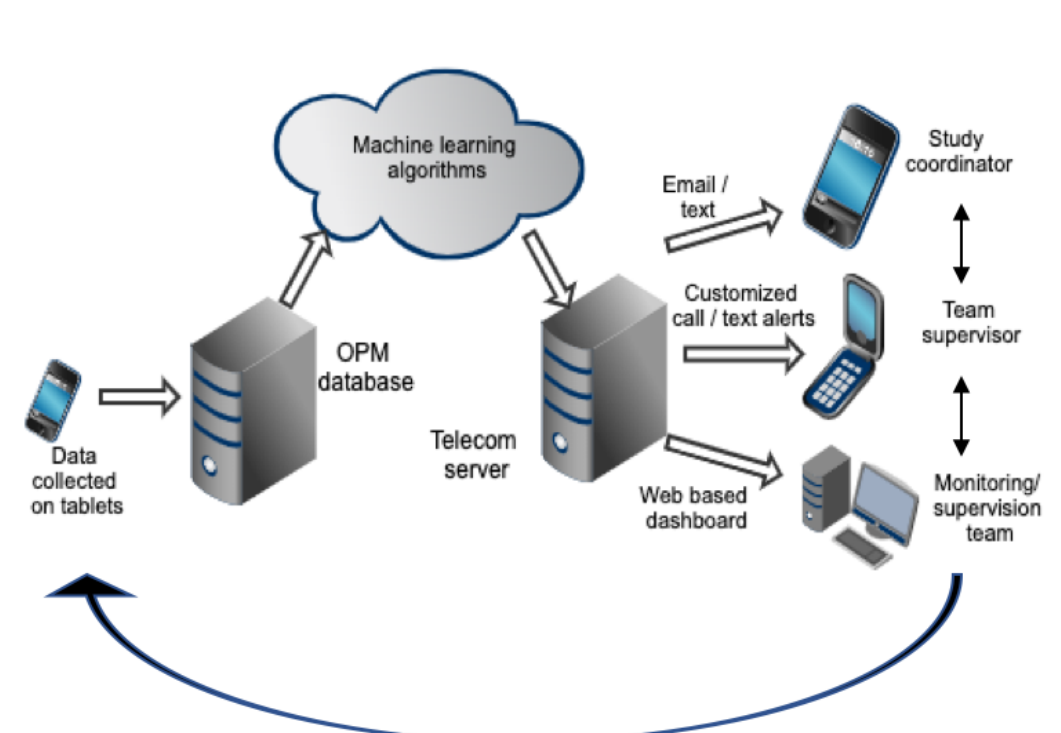
Figure 3. Automated feedback